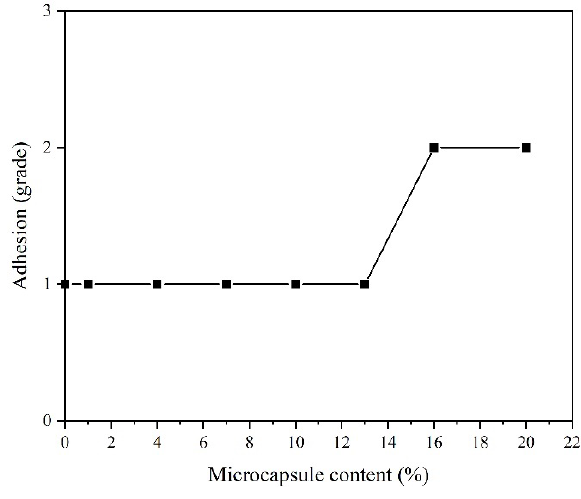
Figure 9. Adhesion grade of coatings.